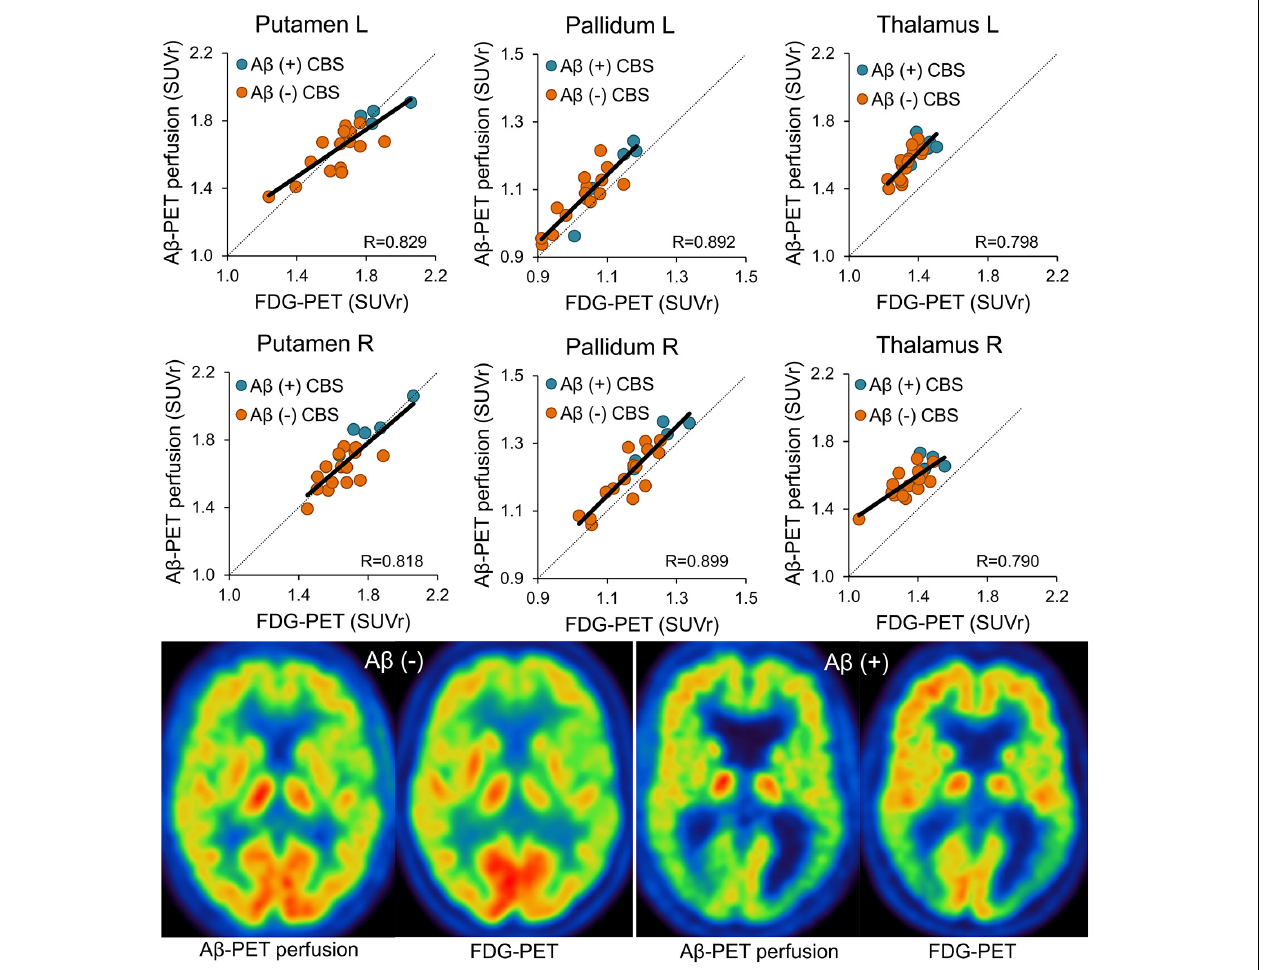
FIGURE 2 | Agreement between early phase A β -PET and FDG-PET for subcortical regions. Plots in the upper two rows show correlation of both modalities for all subcortical regions. Images in the lower row illustrate patient examples for A β -negative and A β -positive cases. Images show corresponding axial planes for early-phase A β -PET and FDG-PET. The color scale of early phase A β -PET and FDG-PET images was set to the maximum signal intensity. SUVr, standardized-uptake-value-ratios; FDG-PET, 18 F-fluorodesoxyglucose positron-emission-tomography; SD, standard deviation; L, left; R, right; LAT, lateral; SUP, superior; INF, inferior; ANT, anterior; POST, posterior; MED, medial; A β , β -amyloid; R , Pearson’s coefficient of correlation; CBS, corticobasal